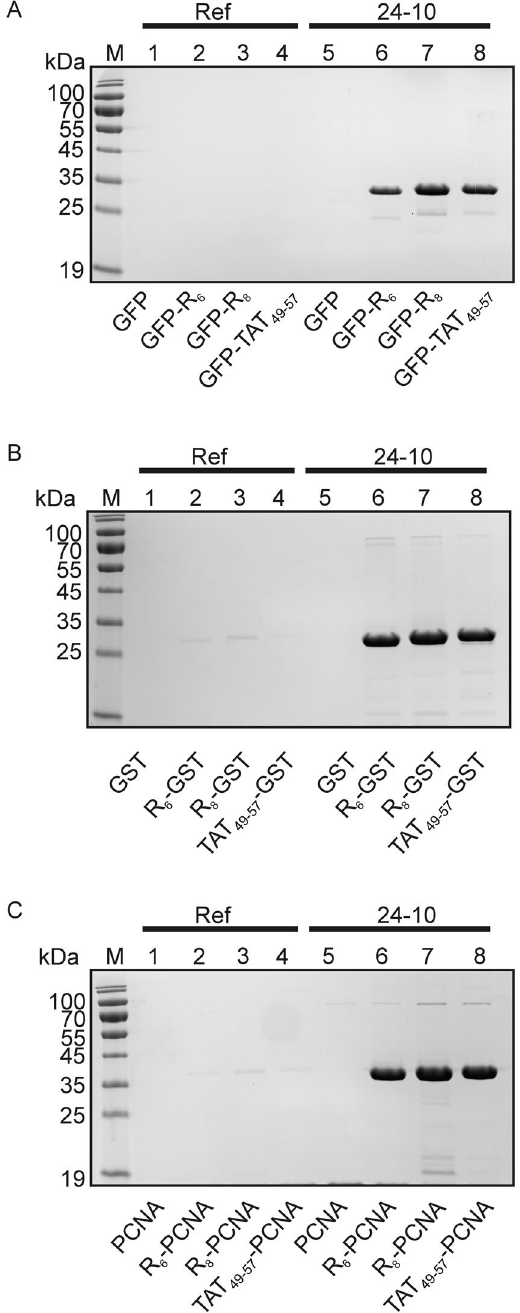
Figure 4. Analysis of the 24–10 aptamer specificity. 5 ′ -biotinylated reference (Ref) (lanes 1–4) or 24–10 (lanes 5–8) aptamer immobilized to streptavidin-agarose resin was incubated with appropriate variants of ( A ) GFP, ( B ) GST and ( C ) PCNA proteins. Protein without tag (lanes 1, 5), protein with R 6 tag (lanes 2, 6), protein with R 8 tag (lanes 3, 7), protein with Tat 49–57 tag (lanes 4, 8). After washing, the protein sample was denatured and half of the protein sample volume of the bound protein was separated on 12% SDS-PAGE gel followed by Coomassie brilliant blue staining. This is one of three independent experiments which is